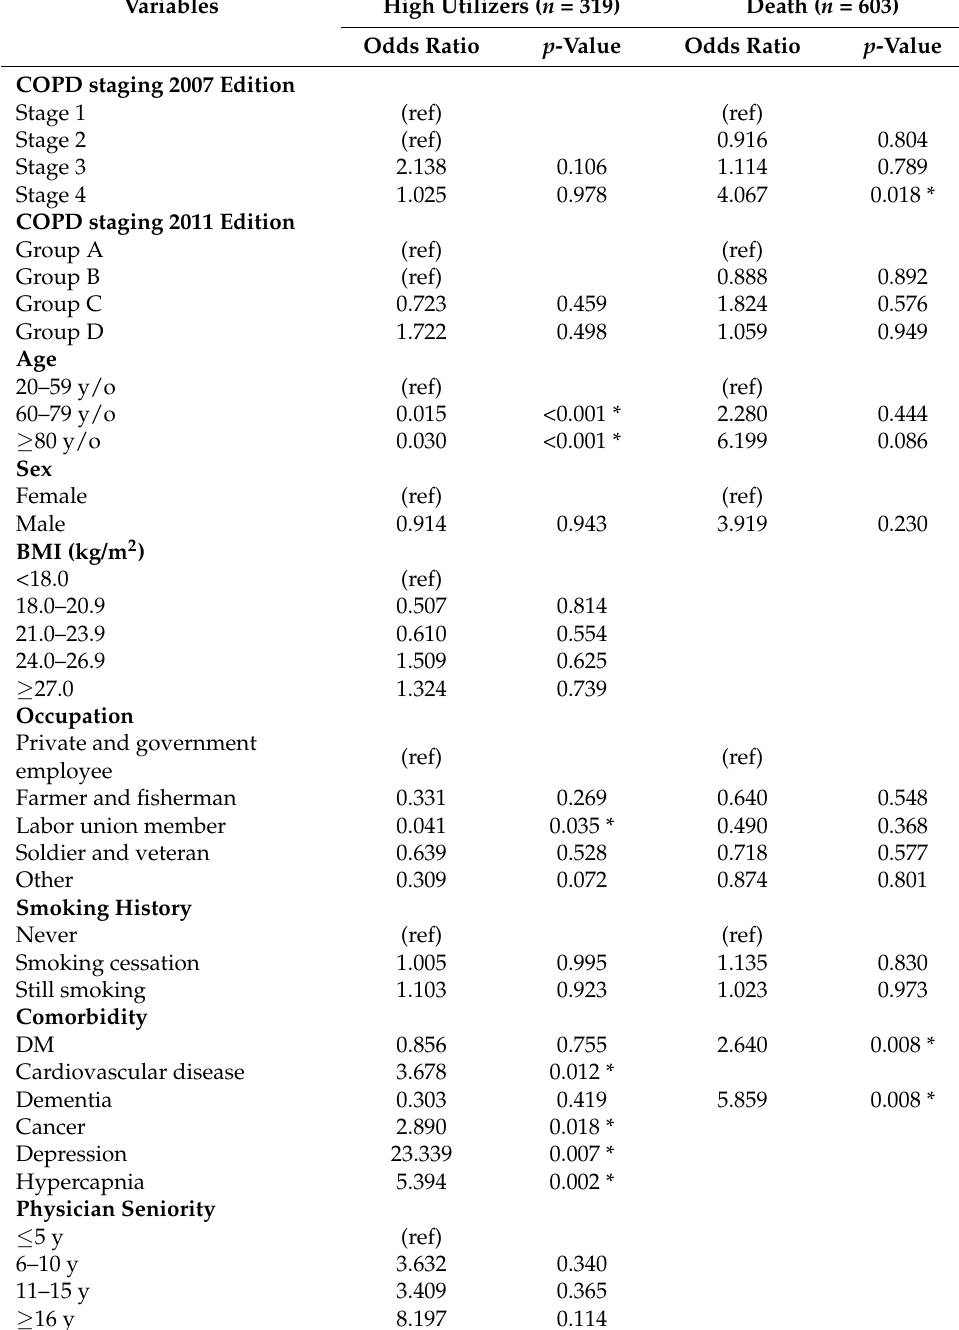
Table 4. Logistic regression model of high medical utilization and mortality stay in COPD